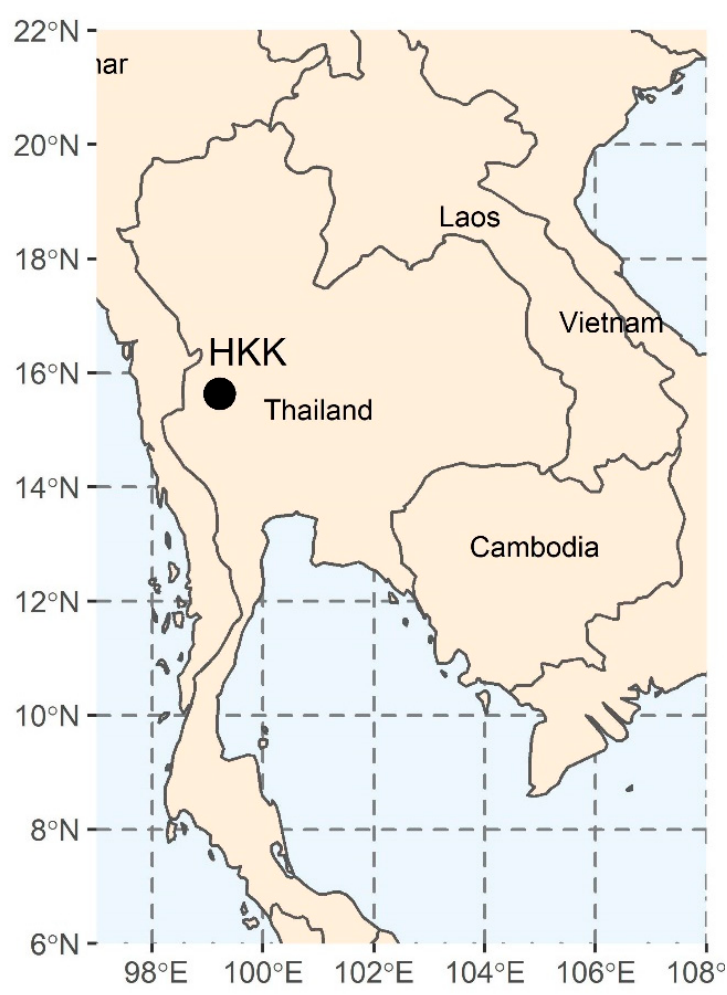
Figure 1. Map of Huai Kha Khaeng (HKK) Wildlife Sanctuary where the study area is located within. All trees in the HKK FDP with diameter at breast height (DBH; measured at 1.3 m above the ground) ≥ 1 cm were tagged, measured, identified to species, and mapped following a standard protocol [30–32]. The HKK FDP has been censused every five years since 1994; there have been six censuses. The plot contains almost 300 tree species, including 190 genera and 65 families (Figure 2). The Euphorbiaceae family has the most abundant species, Croton roxburghii . The Dipterocarpaceae family is most dominant by basal area, led by Hopea odorata [29]. Approximately 200 trees have diameters larger than 100 cm, including individuals of H. odorata , Anisoptera costata , Dipterocarpus alatus , Lagerstroemia tomentosa , and several species of Ficus